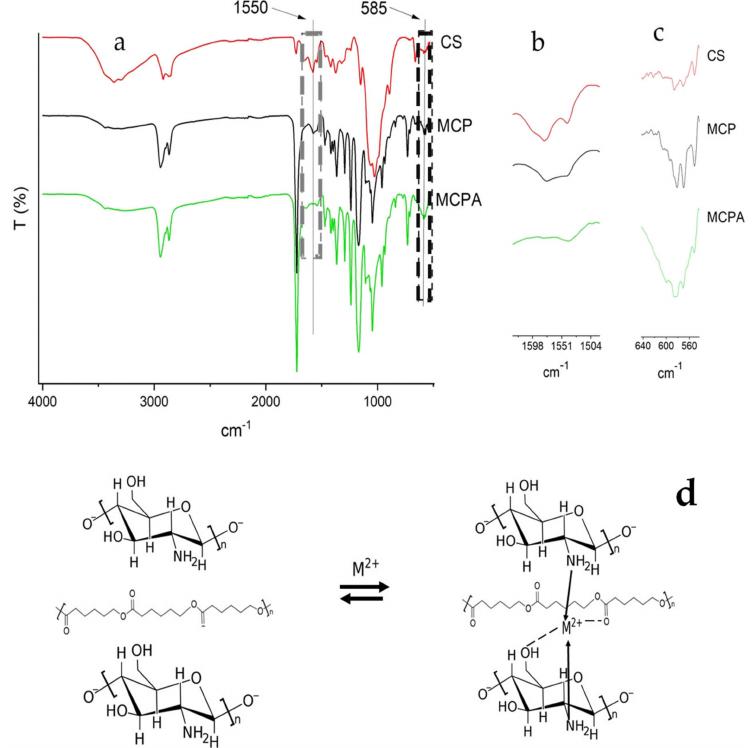
Figure 5. FTIR spectra of CS, PCL, and MCP, before and after adsorption treatment (MCPA) ( a ), 1650–1400 cm − 1 ( b ), and 650–550 cm − 1 regions ( c ), and proposed adsorption mechanism ( d ). The grey box represents N-H bending vibrations. The black box shows the stretching vibrations of the metal ion-MCP